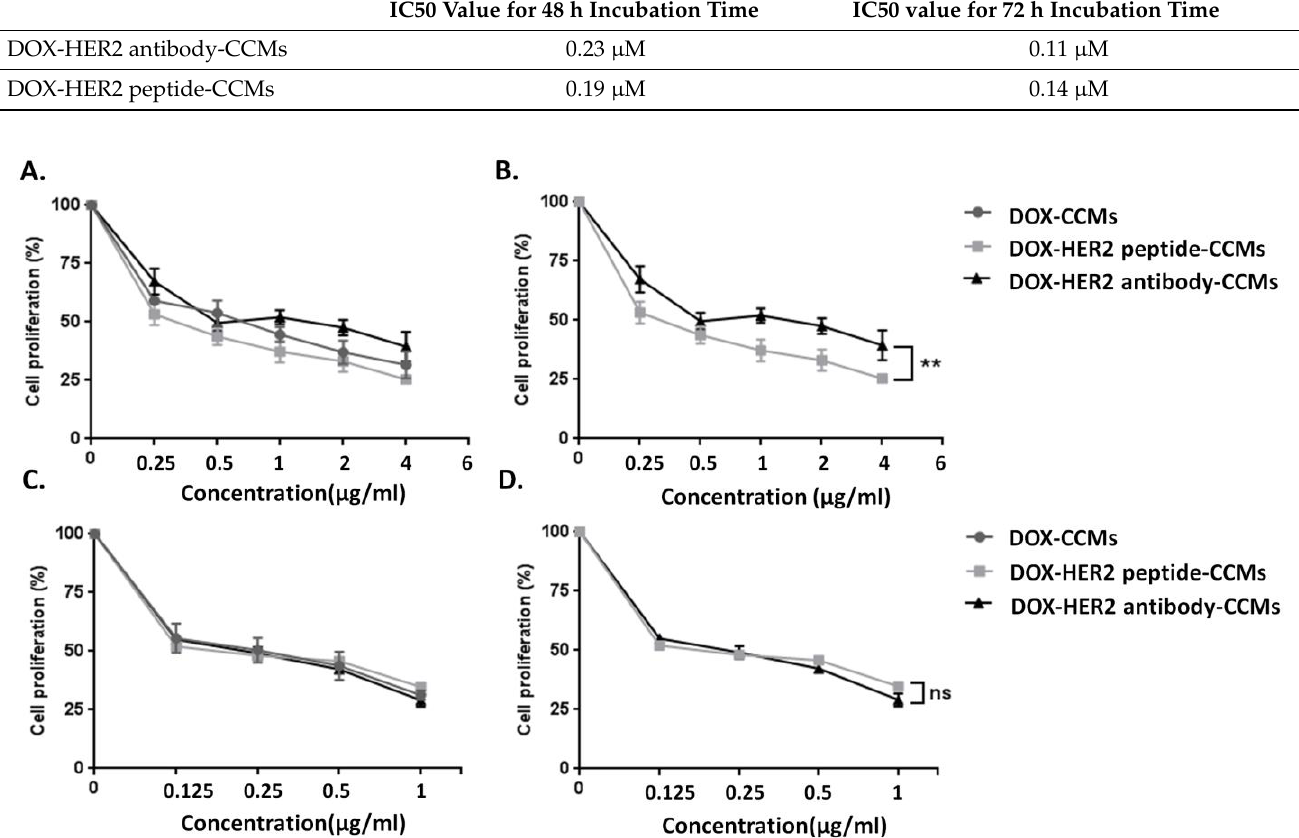
Figure 5. Cytotoxic effect of DOX-CCMs, DOX-HER2 peptide-CCMs, and DOX-HER2 antibody- CCMs (0–4 µ M) on SKBR-3 ( A , B ) and (0–1 µ M) MCF-10A ( C , D ) cells for 48 h. Note that, in all cyto-